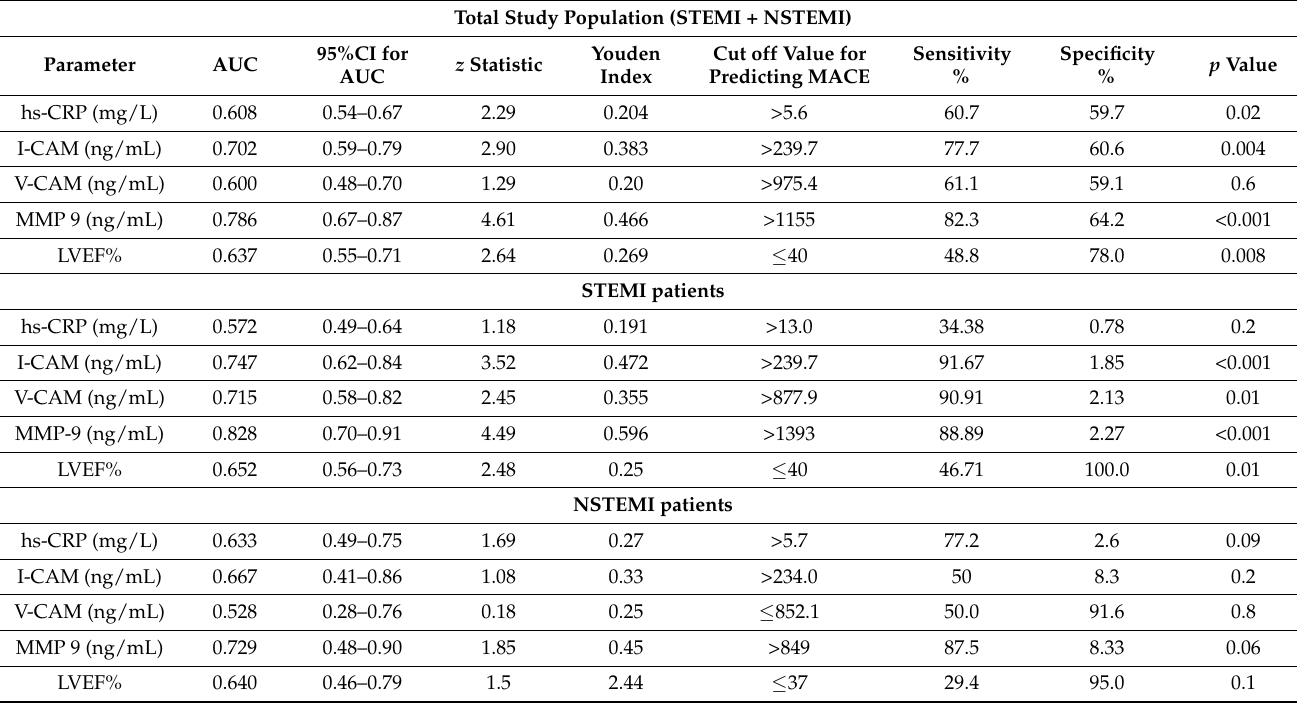
Table 4. ROC curve analysis for serum and imaging markers in predicting